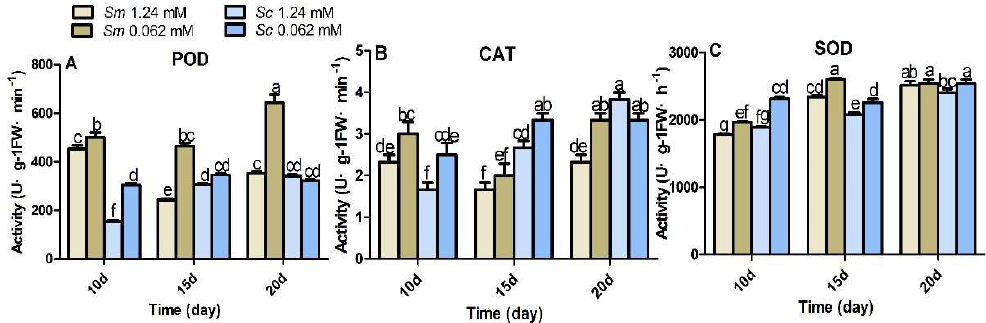
Figure 6. Antioxidant enzyme activities in hairy roots under control and Pi-deficient conditions. Sm , S. miltiorrhiza ; Sc , S. castanea ; different letters indicate significant differences by applying Duncan’s multiple range test.